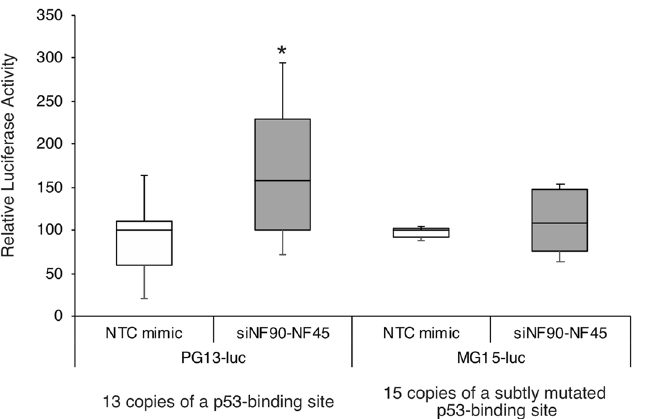
Figure 5. Analysis of p53 signaling in β cell lines depleted of NF90 and NF45. PG13-luc (wt p53 binding sites) and MG15-luc (mut p53 binding sites) were transfected into BTC6 cells treated with either siNTC or